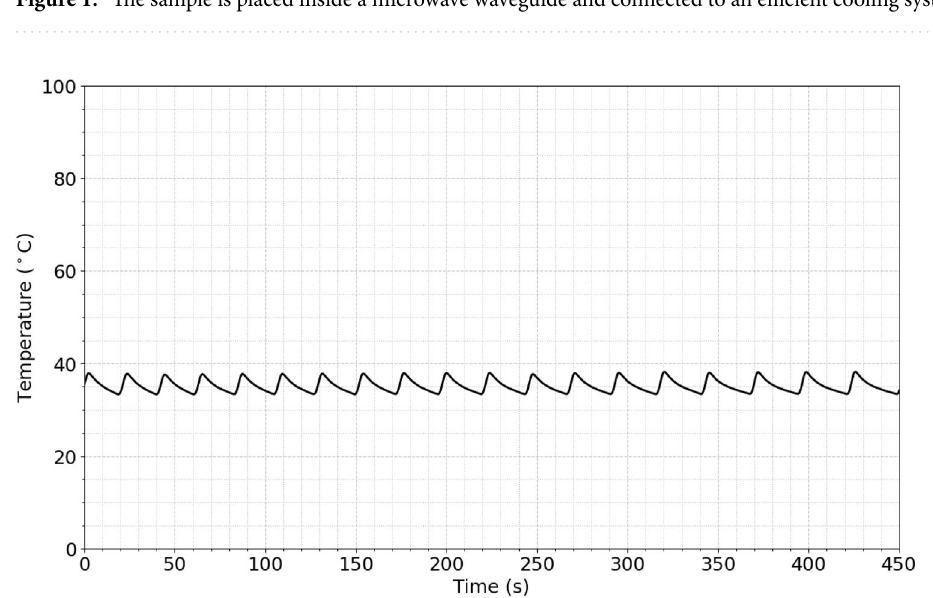
Figure 2. Stability of the temperature of the sample under high-power microwave